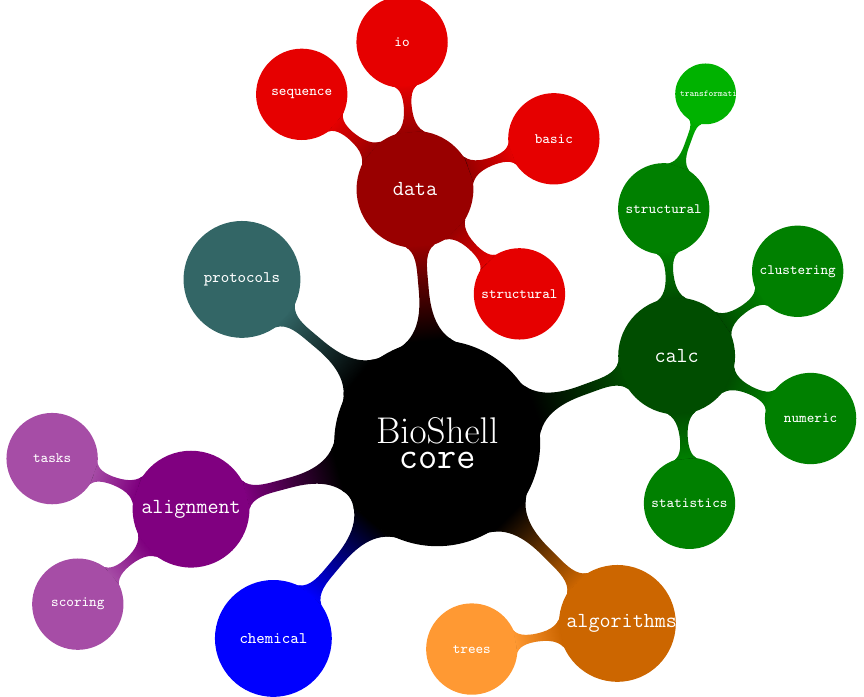
Figure 1. Organization of BioShell source tree—core